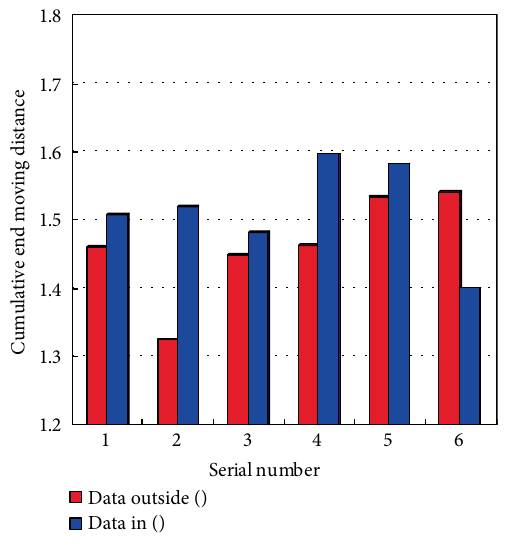
Figure 8: A comparison chart of Δ𝑋 sum when there is an obstacle.